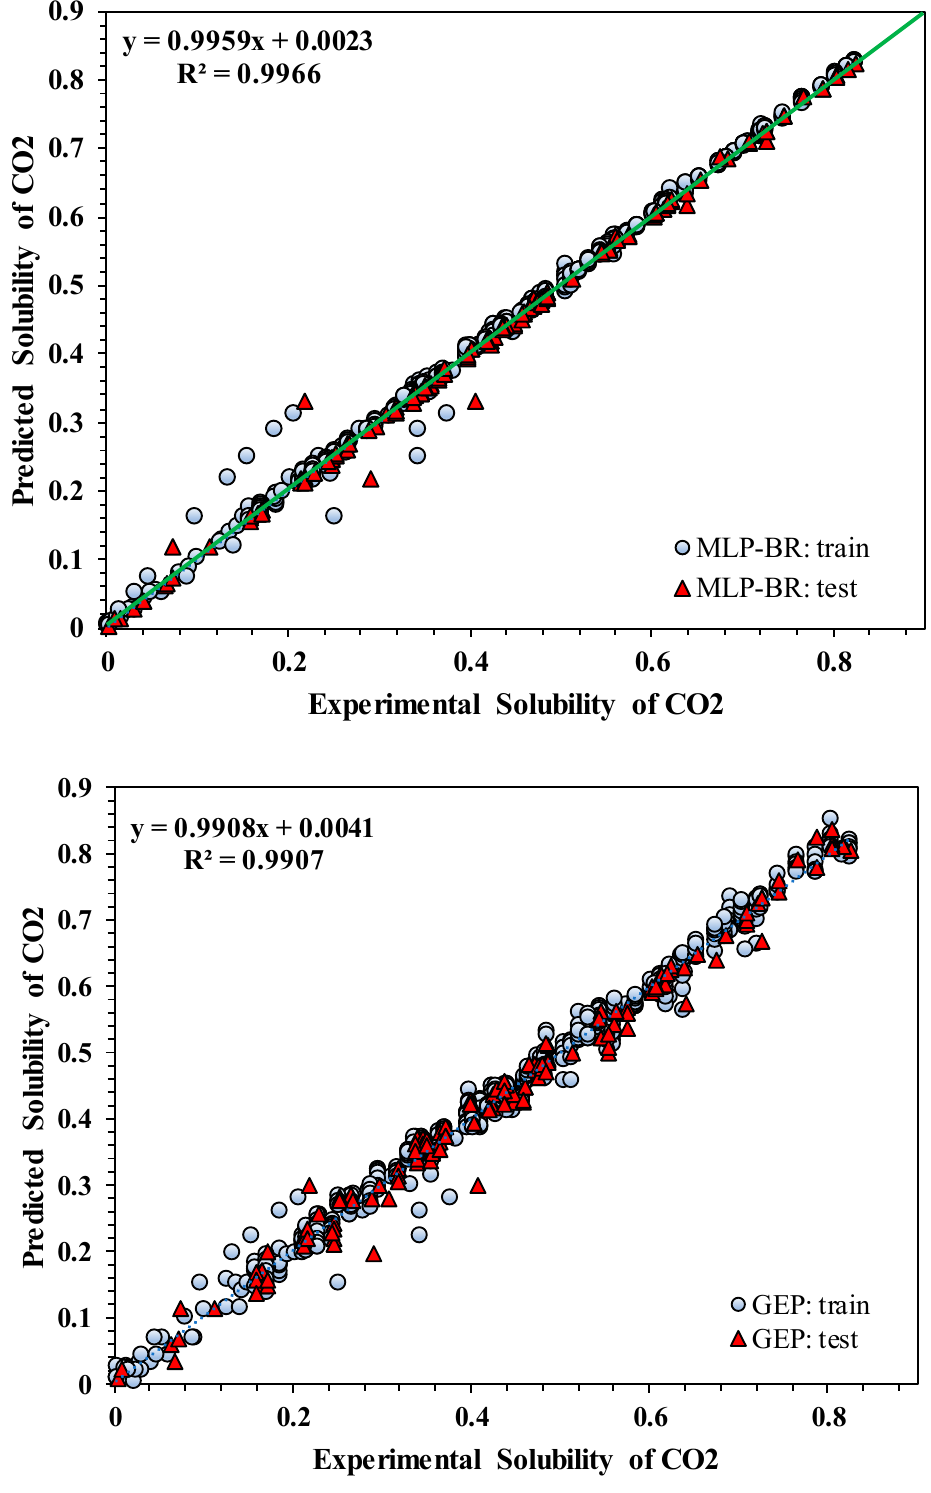
Figure 3. Cross plots of the proposed predictive models.